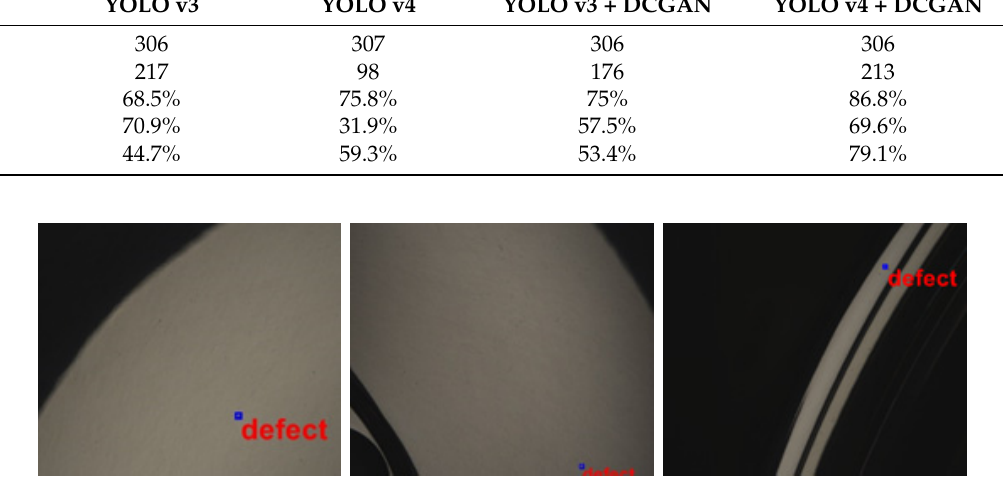
Figure 26. Photographs showing the locations of defects.